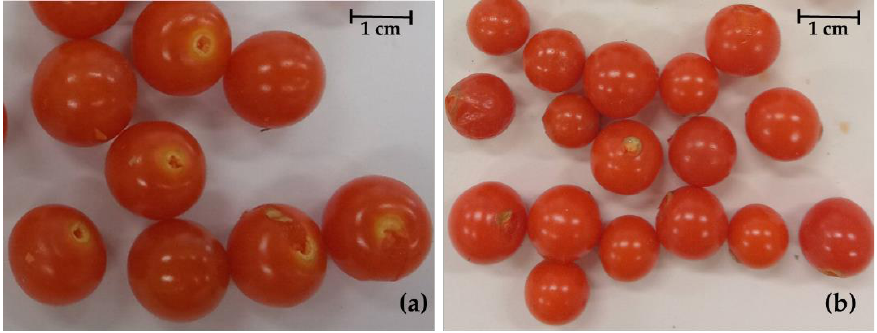
Figure 1. Physalis alkekengi L. fruit (de-husked): ( a ) fruit from north-eastern Bulgaria, PA-NB; ( b ) fruit from central Southern Bulgaria, PA-SB. Photos by authors.